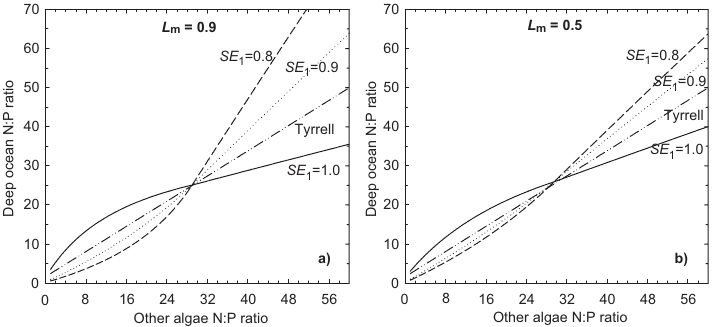
Fig. 8. Simulated deep ocean N:P ratio vs. non-fixers N:P ratio ( R O org ), using a maximum accumulation efficiency for herbivores of (a) L m =0.9 and (b) L m =0.5. Different values of the fractions of excretion occuring in the surface of the ocean (SE 1 ) were also used. The other parameters were kept similar with base run (Table 1).